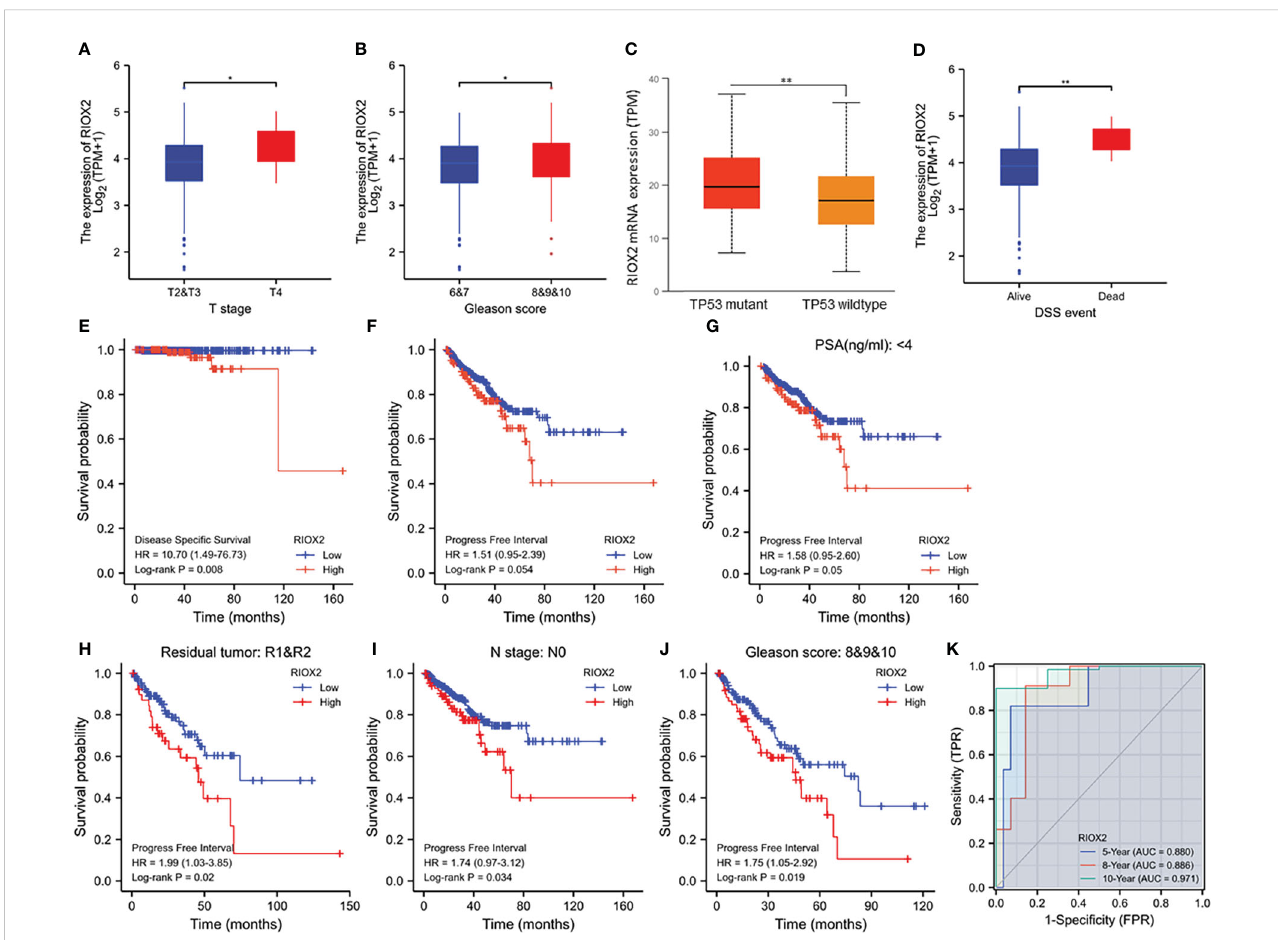
FIGURE 4 RIOX2 upregulation is associated with disease progression and patients ’ survival outcomes in prostate cancers. (A – D) RIOX2 mRNA expression levels were compared in the TCGA-PRAD dataset between different groups strati fi ed with tumor stage, Gleason scores, TP53 gene mutation status, and patient survival status as indicated. The asterisks indicate a signi fi cant difference (Wilcoxon rank sum test, *p < 0.05; **p < 0.01). Case numbers in each group are as follows: T2, 189; T3, 292; T4, 11; Gleason scores 6, 46; Gleason scores 7, 247; Gleason scores 8, 64; Gleason scores 9, 138; Gleason scores 10, 4; TP53 mutant, 38; TP53 wild-type, 295; DSS alive, 492, DSS deceased, 5. (E – J) Kaplan-Meier survival analysis was conducted by stratifying patients using the minimum p -value approach (18) based on RIOX2 expression levels and clinicopathological features. TMEM158 expression data were extracted